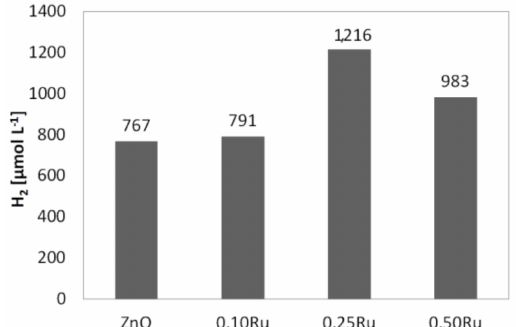
Figure 4. E ff ect of Ru content on H 2 production after 4 h of UV irradiation time.